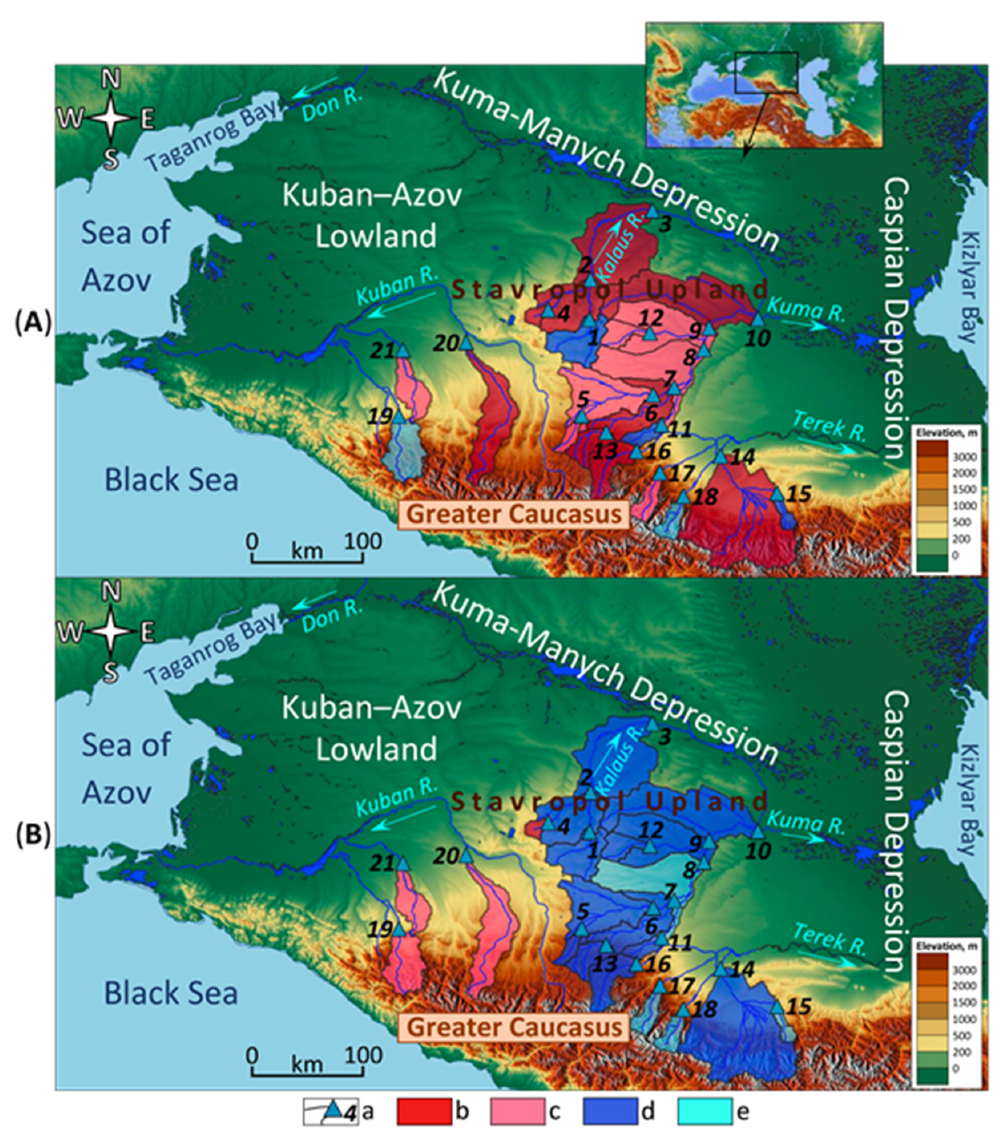
Figure 11. Trend changes in mean annual water discharge ( A ) and mean annual suspended sediment load ( B ) of the studied rivers in the North Caucasus region (SW Russia) between 1963–1980 and 2008–2017. a—analyzed hydrological stations (with river basin borders) on the rivers (see Figure 1, Table 1); trend changes : b—a statistically significant ( p ≤ 0.05) increase, c—a statistically insignificant ( p > 0.05) increase, d—a statistically significant decrease, e—a statistically insignificant decrease.